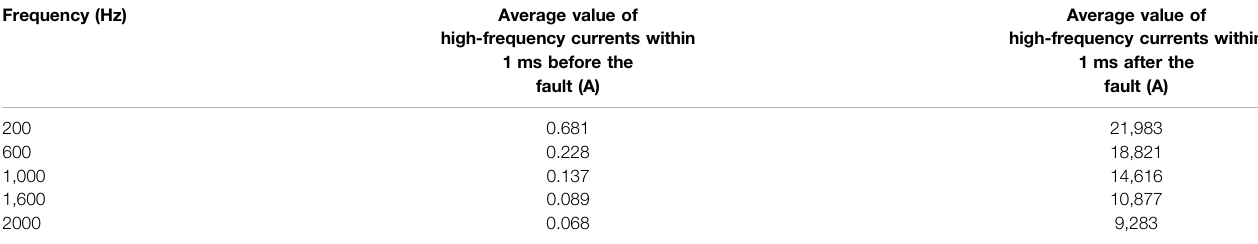
TABLE 3 | Simulation results of high-frequency current before and after fault with different characteristic frequencies of high- frequency